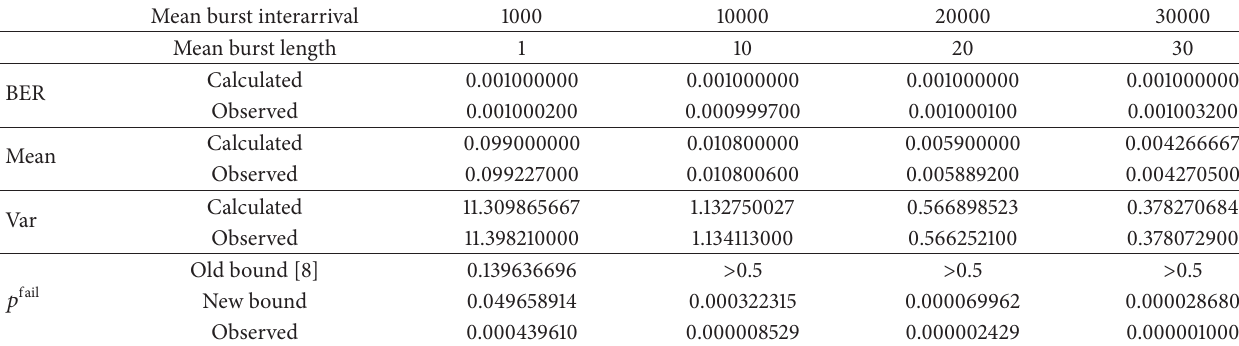
Table 1: Comparison of analytical and stochastic simulation